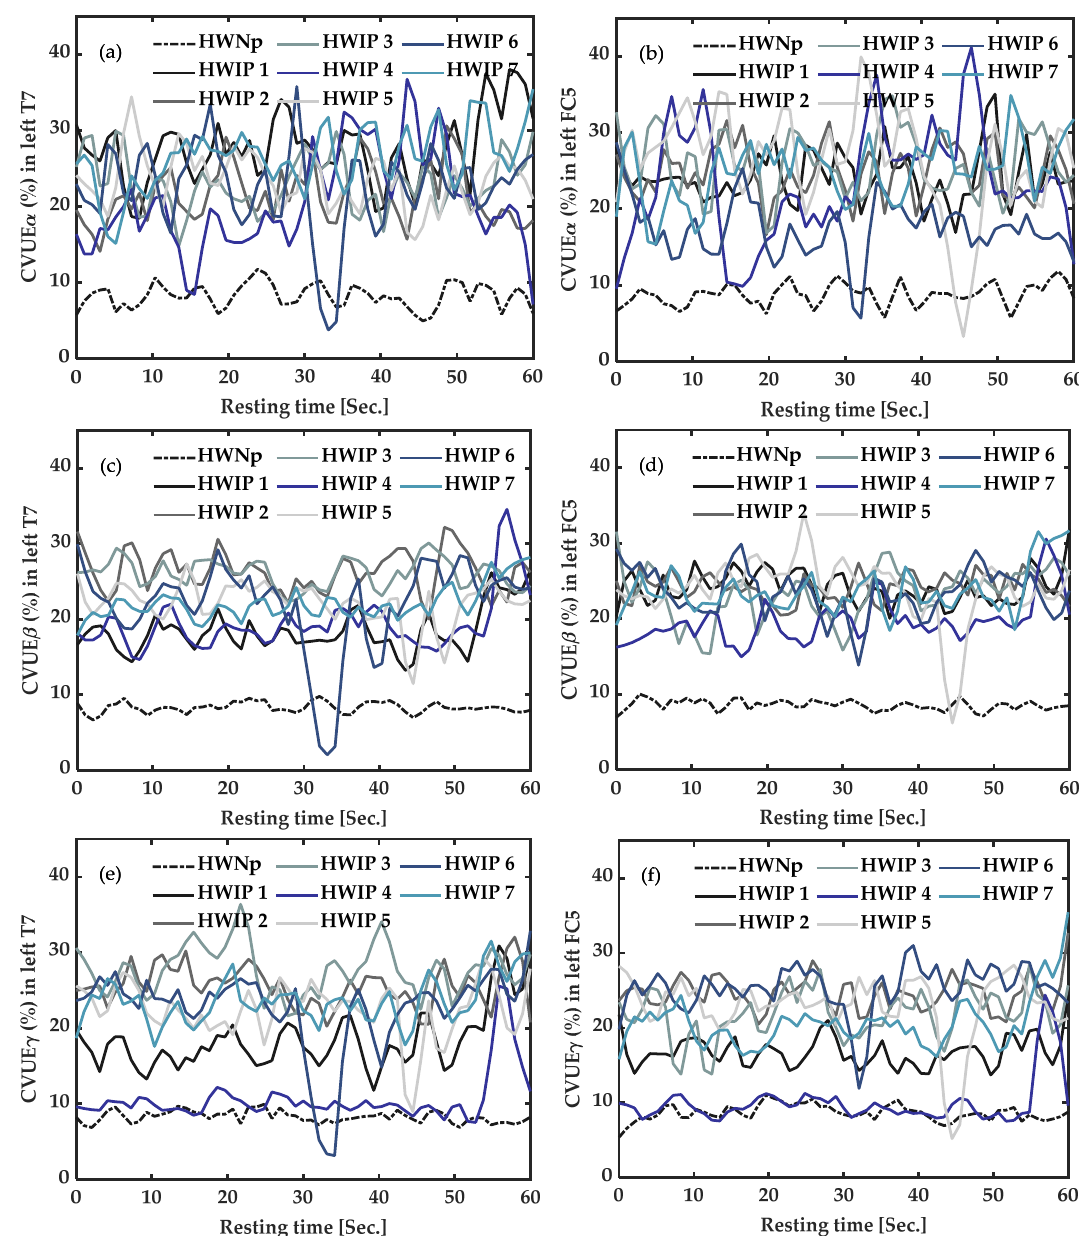
Figure 4. Baseline measures of the coefficient of variation of upper envelope (CVUE) in alpha (CVUE α ), beta (CVUE β ) and gamma (CVUE γ ) at rest. ( a )—CVUE α from left temporal (T7) data, ( b )—CVUE α from left fronto-central (FC5) data, ( c )—CVUE β from left temporal (T7) data, ( d )—CVUE β from left fronto-central (FC5) data, ( e )—CVUE γ from left temporal (T7) data, ( f )—CVUE γ from left fronto-central (FC5) data. The black dotted line indicates the average of CVUE of healthy with “No pain” (HWNp). The colored lines represent CVUE of the seven healthy subjects with induced pain (HWIP 1-7 ). The graphs were smoothed by a 5th-order of Savitzky–Golay filter. CVUE β from FC5 data were significantly increased in all HWIP.